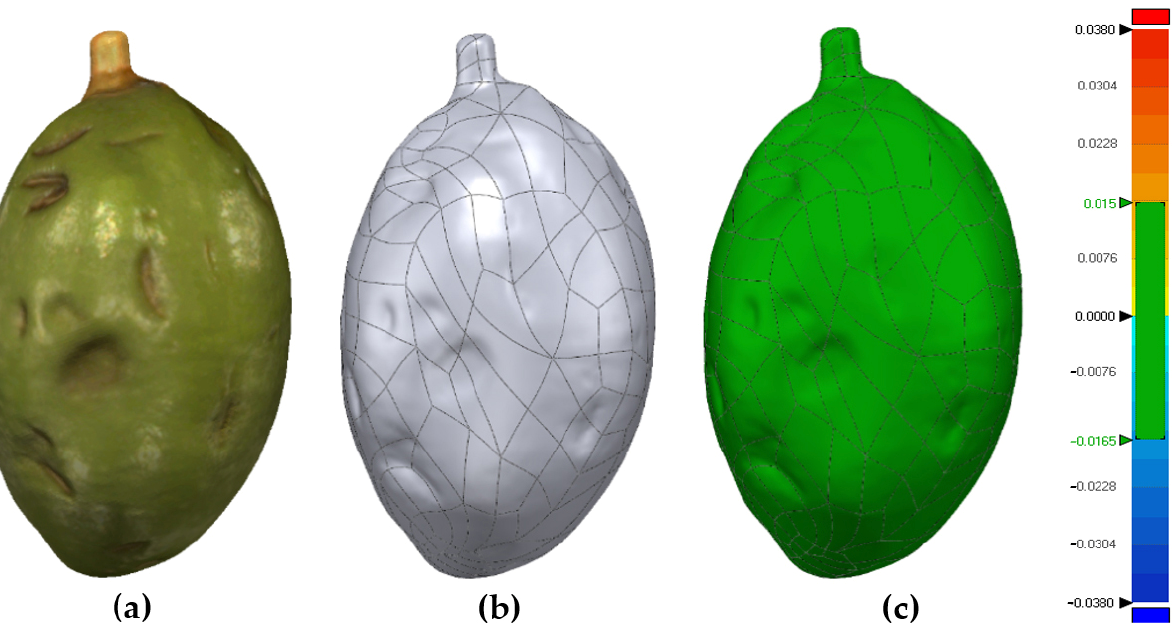
Figure 8. NURBS model of virtual olive: ( a ) virtual olive; ( b ) NURBS surfaces, and ( c ) surfaces deviation. 